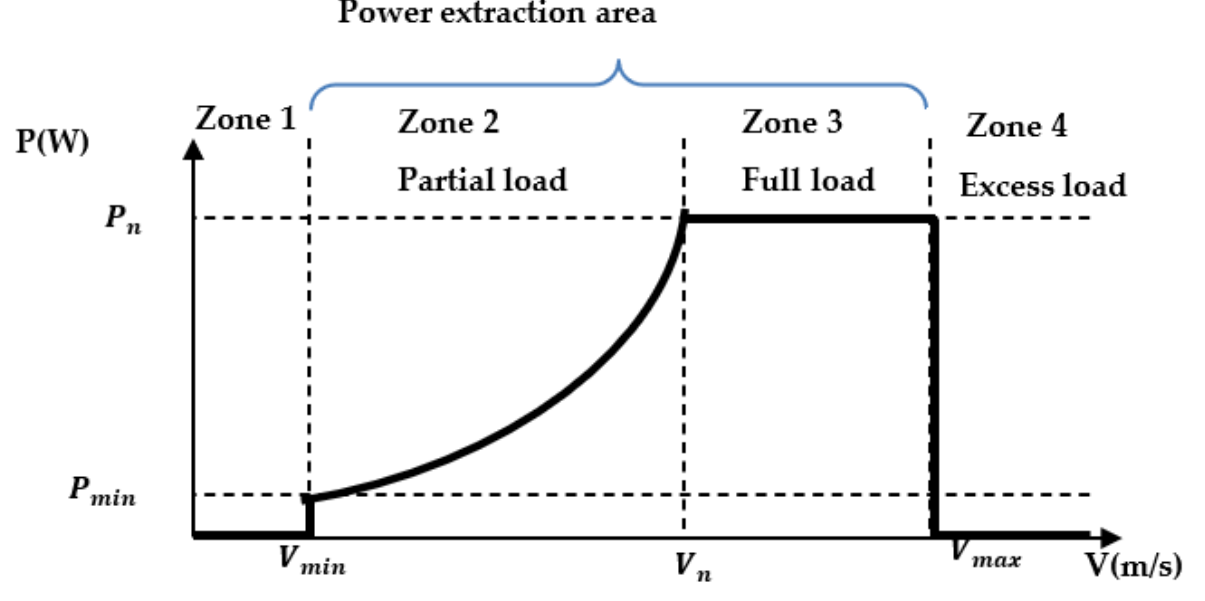
Figure 1. Operating zones of the wind turbine [22].